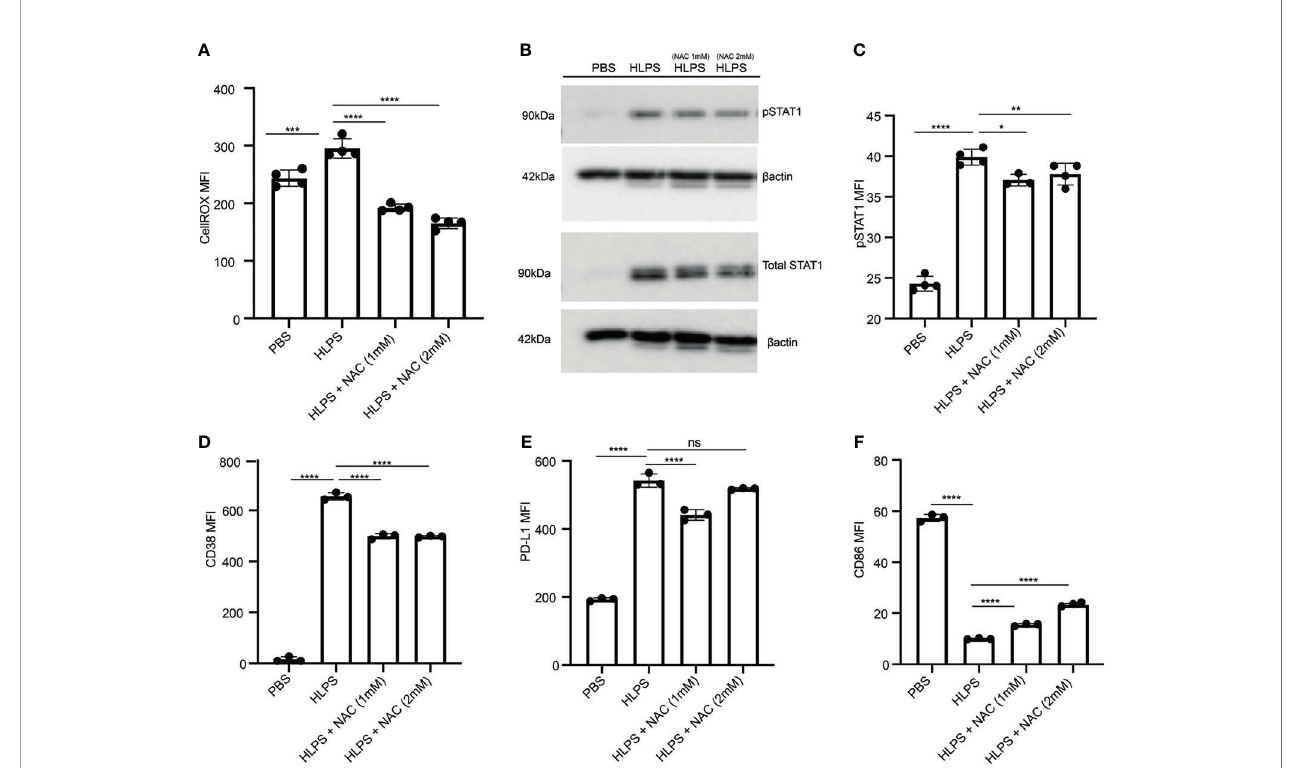
FIGURE 5 | Scavenging ROS reduces STAT1 activation and monocyte exhaustion. BMDMs were stimulated with PBS or high dose LPS (100 ng/mL) for 5 days, and NAC was added to indicated cultures. (A) Intracellular ROS level was measured with fl ow cytometry, n=4. (B, C) The protein expression and phosphorylation of STAT1 was determined using Western blot, n=3 (B) and fl ow cytometry, n=4 (C) . (D – F) The MFIs of CD38 (D) , PD-L1 (E) and CD86 (F) were determined using fl ow cytometry, n=3. The data are representative of at least three independent experiments, and error bars represent means ± SEM. *p < 0.05, **p < 0.01, ***p < 0.001, ****p < 0.0001, ns: non-signi fi cant, one-way